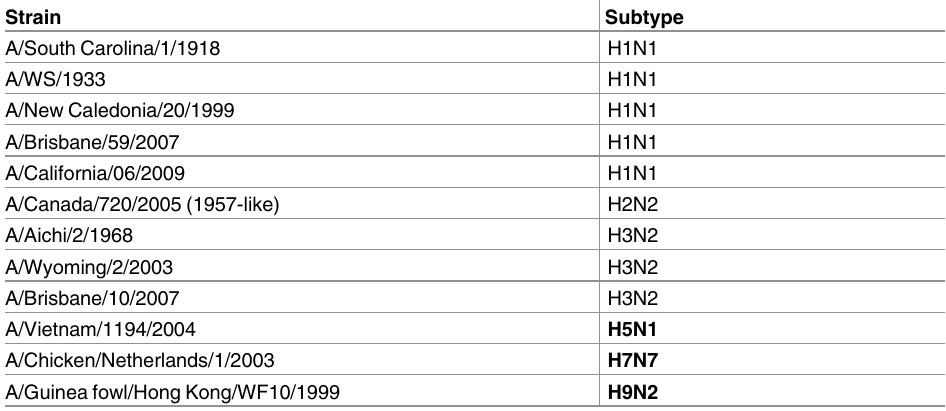
Table 1. Antigens included in the